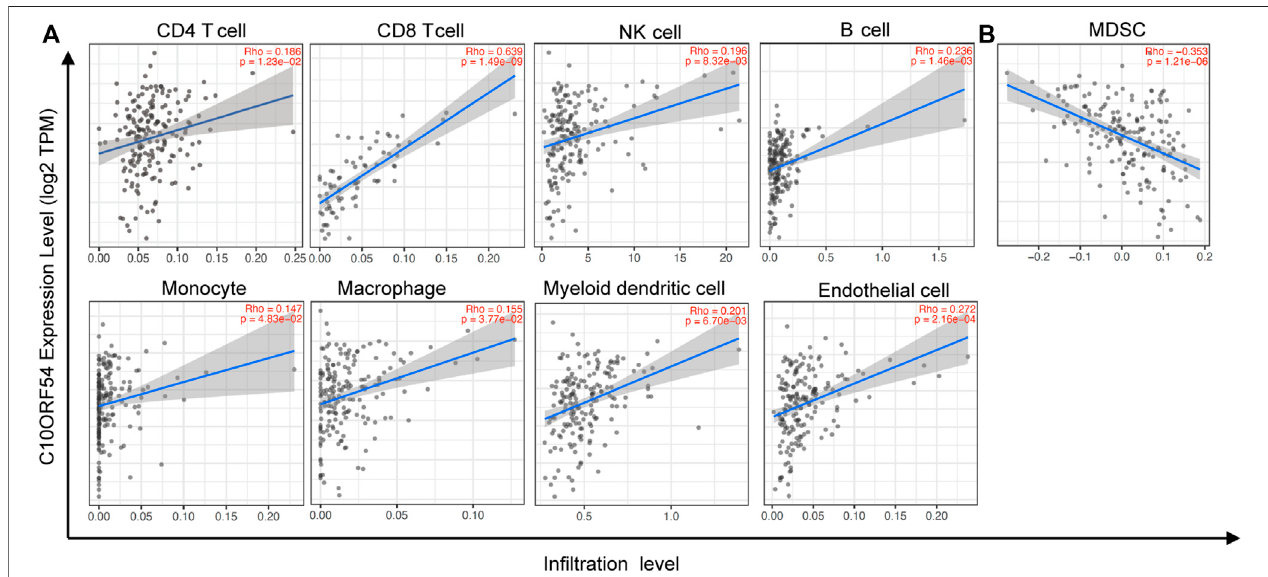
FIGURE3| TherelationshipsofPD-1Hexpressionwithimmunecellin fi ltrationwereassessedinESCCbasedonTCGAdatabase.TheCIBERSORTalgorithmwas used to identify the immune cell in fi ltration signatures. (A) Positive correlations of PD-1H with CD4 + T cells (Rho (cid:2) 0.186, p (cid:2) 0.012), CD8 + T cells (Rho (cid:2) 0.639, p < 0.001),CD68 + macrophages (Rho (cid:2) 0.155, p (cid:2) 0.038),CD1c + myeloid dendritic cells (Rho (cid:2) 0.201, p (cid:2) 0.007), CD14 + monocytes (Rho (cid:2) 0.147, p (cid:2) 0.048), CD56 + NK cells(Rho (cid:2) 0.196, p (cid:2) 0.008),CD20 + Bcells(Rho (cid:2) 0.236, p (cid:2) 0.001),andCD31 + endothelialcells(Rho (cid:2) 0.272, p < 0.001). (B) ThenegativecorrelationofPD-1H with CD11b + CD33 + HLA-DR − MDSCs (Rho (cid:2) − 0.353, p < 0.001). CIBERSORT: Cell type Identi fi cation By Estimating Relative Subsets Of RNA Transcripts.